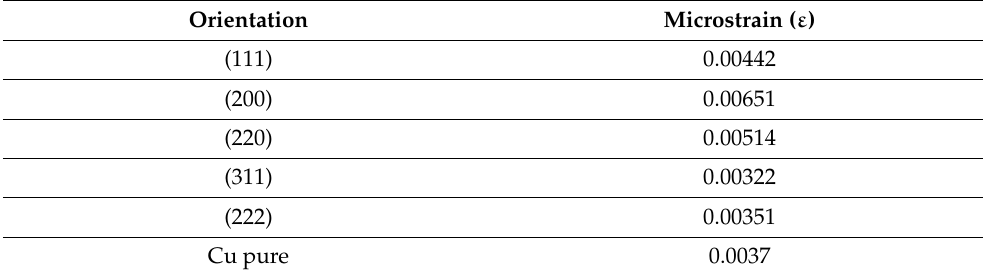
Table 3. The microstrain values of the different